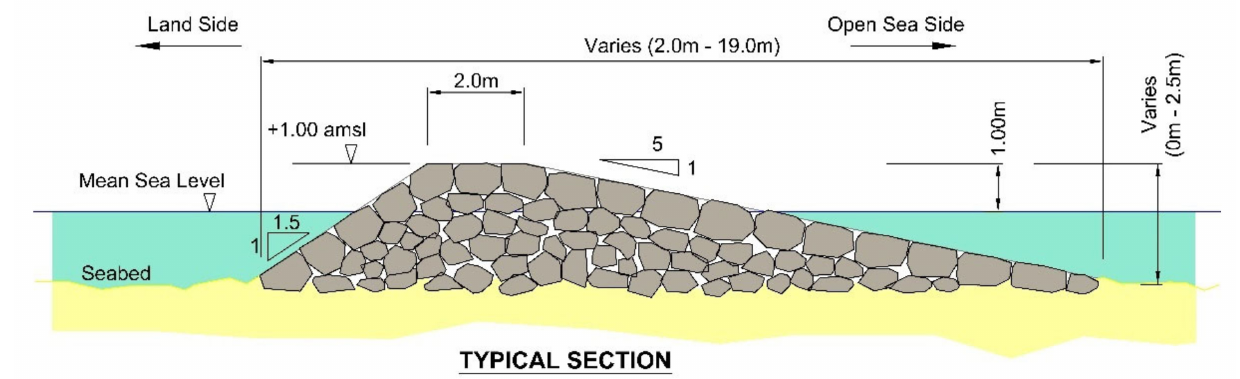
Figure 5. ( a – f ) Evolution of the salient at St Geran (Images from Google Earth). The black line shows the shoreline in June 2021. The February 2018 image ( d ) is after cyclone Berguitta. For scale, the reef is 95 m long. In ( b ), construction was undertaken in August–October 2017.